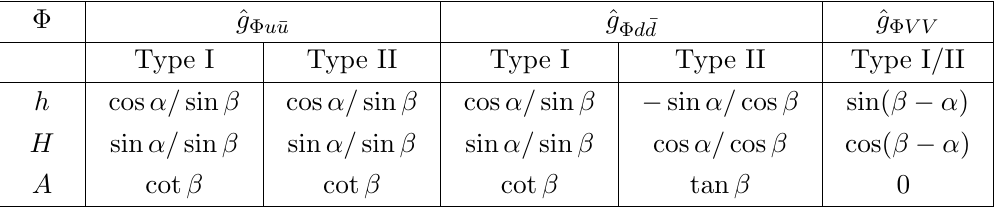
Table 1 . The couplings of the h; H; A bosons to fermions and gauge bosons in Type-I and -II 2HDMs relative to SM Higgs couplings; the H (cid:6) couplings to fermions have factors similar to those of the CP-odd boson A